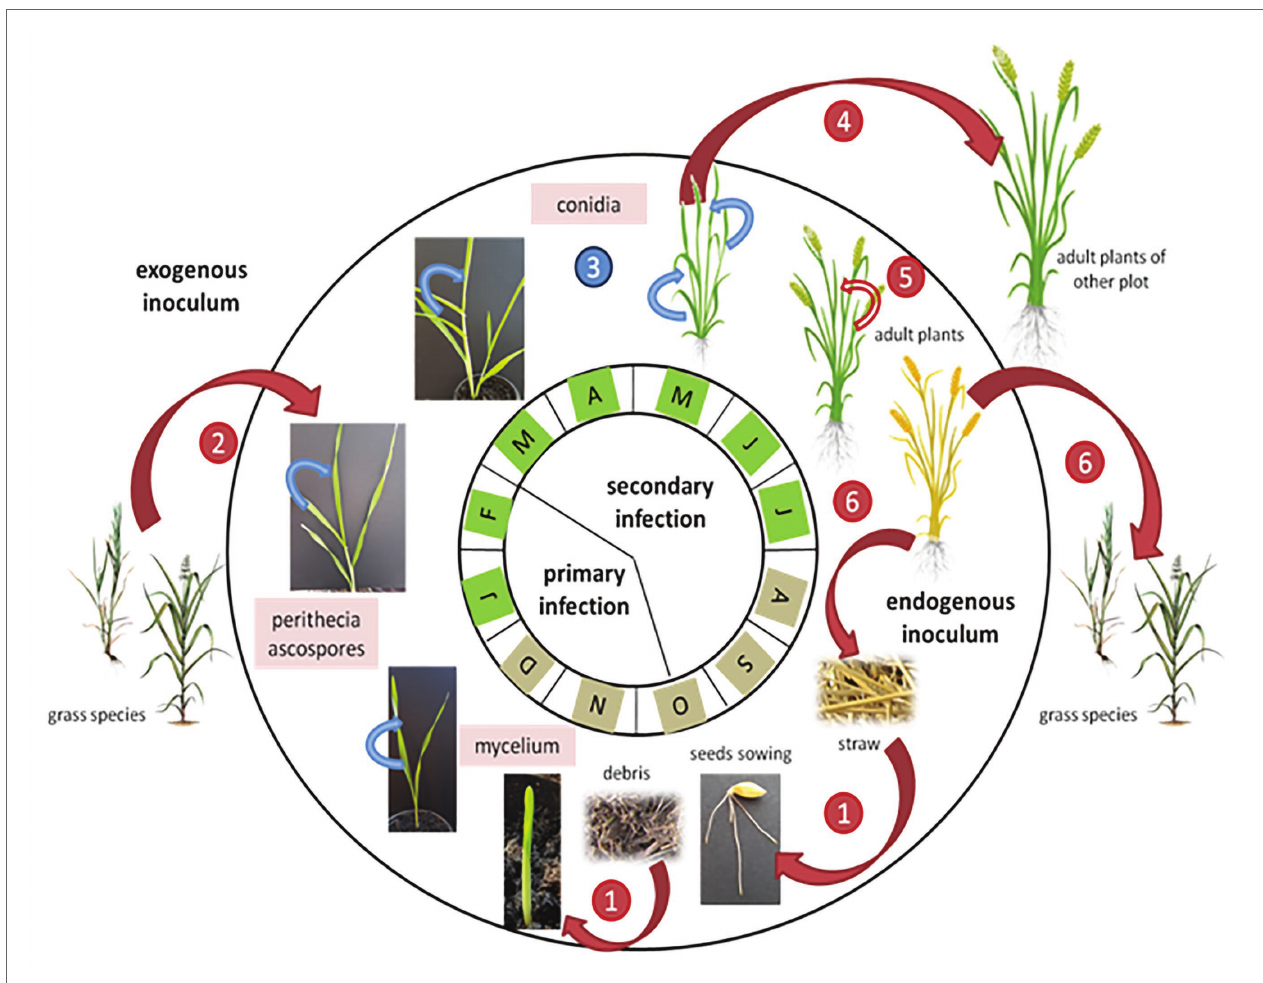
FIGURE 4 | Dynamics of net blotch epidemics adapted from Suffert et al. (2011). Red arrows indicate P. teres wind-dispersed infections and blue arrows indicate splash-dispersed infections. The months with a brown color indicate that the source of inoculum comes from swarming debris on the soil, while the months with a green color indicate a source of inoculum mainly from the aerial parts of the plants. The numbers indicate the pathogen’s infection stages: 1: infection by P. teres ascospores present on infected barley debris; 2: mycelium present on grass species infects barley young plants; 3: the net blotch disease progresses from the bottom to the top of the barley plant; 4: disseminated by the wind, conidia contaminate other barley plants; 5: heavily infected crops show abortion of the ear; and 6: Pyrenophora teres colonizes the senescent tissues and produces perithecia on straw and grass